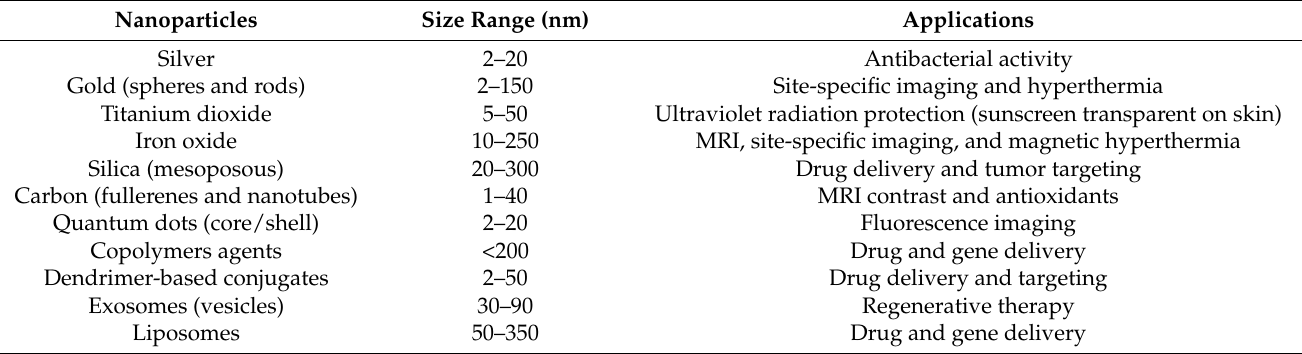
Table 1. Composition and size features of some nanoparticles used in nanomedicine. Adapted from